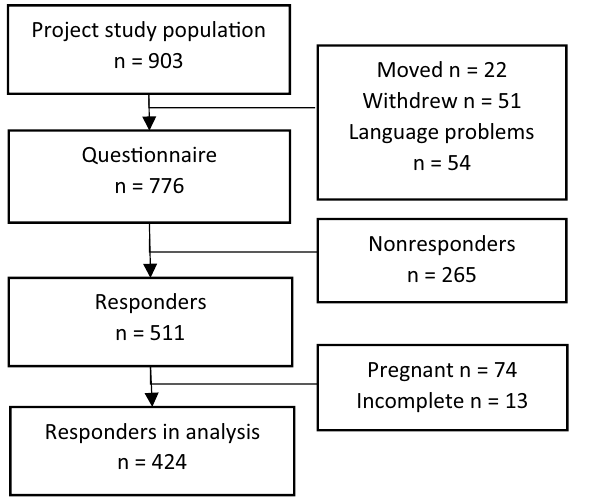
Figure 1. Flow chart of the study population.